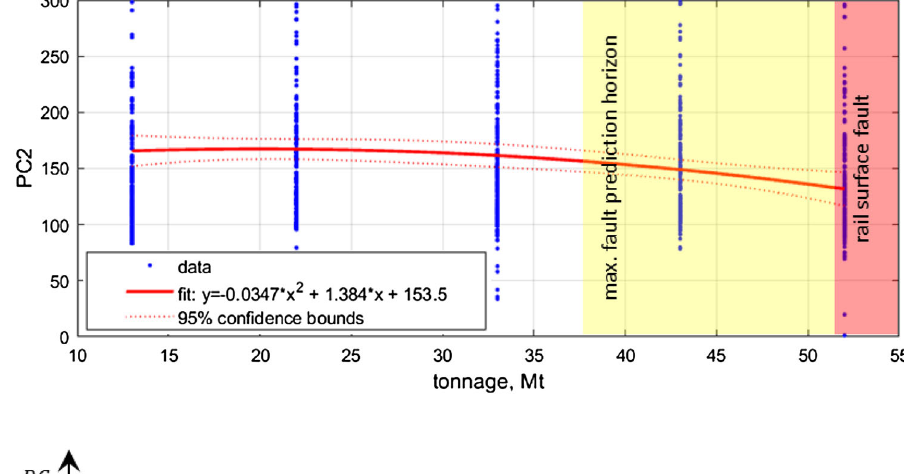
Fig. 16 Assessment of the remaining useful life and